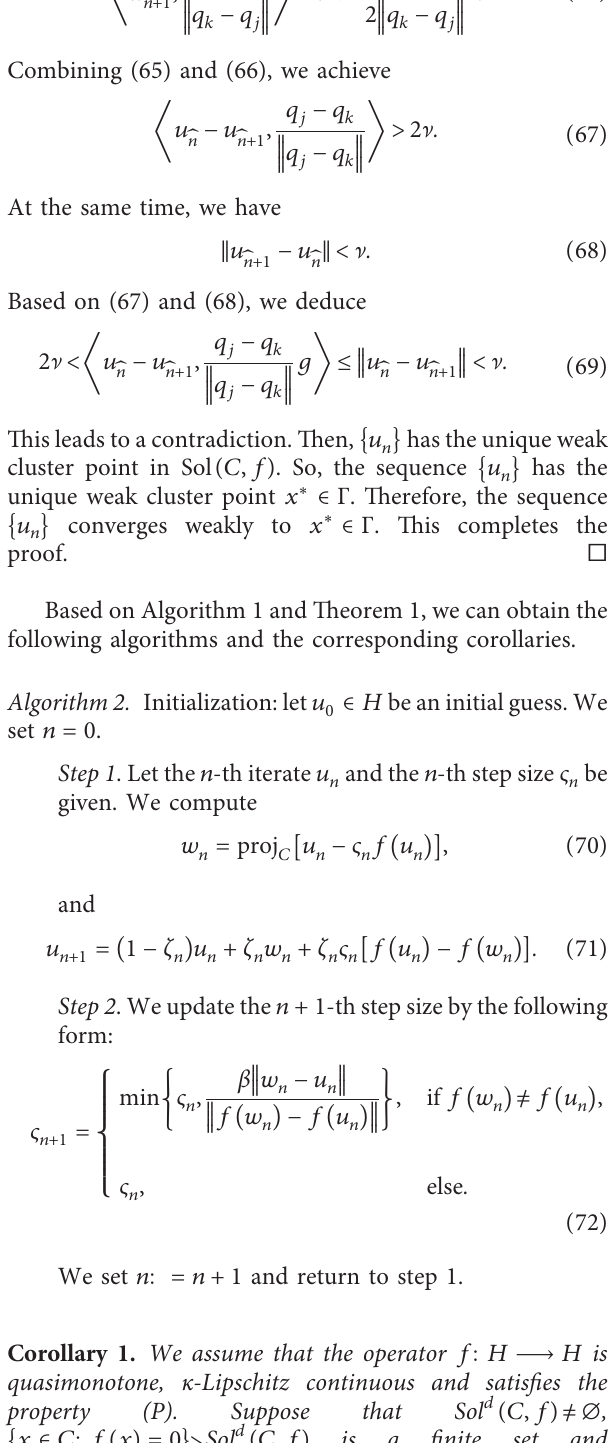
Algorithm 3. Initialization: let u n �